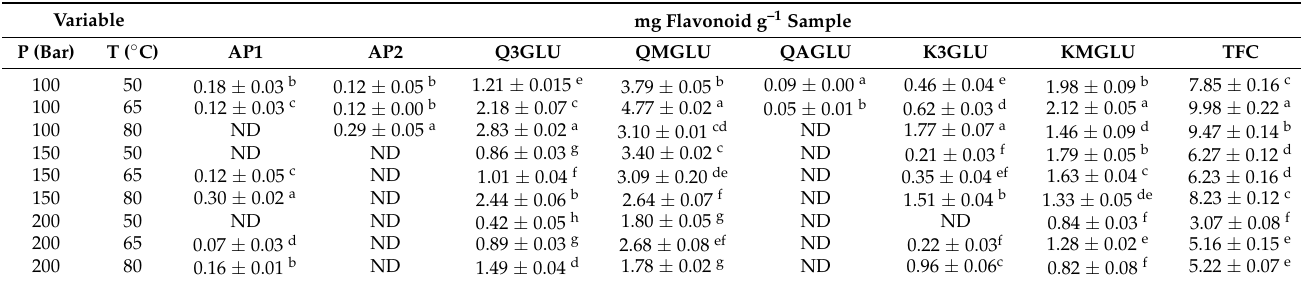
Table 2. Independent variables for the 3 × 3 full factorial design and experimental values obtained for the response variables at a constant ratio of CO 2 and water of 50:50 and 90 min extraction time ( n = 2).